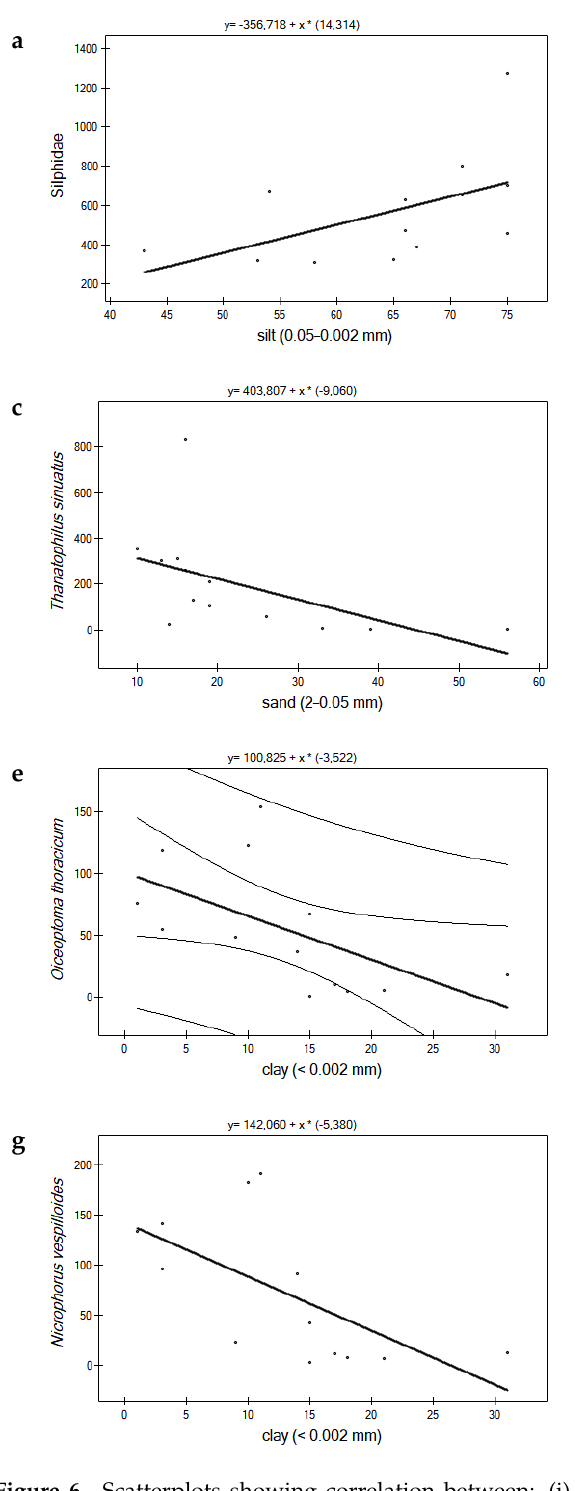
Figure 6. Scatterplots showing correlation between: (i) percentage fraction of silt (0.05–0.002 mm) and numbers of Silphidae ( a ); (ii) percentage fraction of sand (2–0.05 mm) and numbers of P. atrata atrata ( b ), T. sinuatus ( c ), N. vespilloides ( d ); percentage fraction of clay (<0.002 mm) and numbers of O. thoracicum ( e ), T. sinuatus ( f ) and N. vespilloides ( g ).